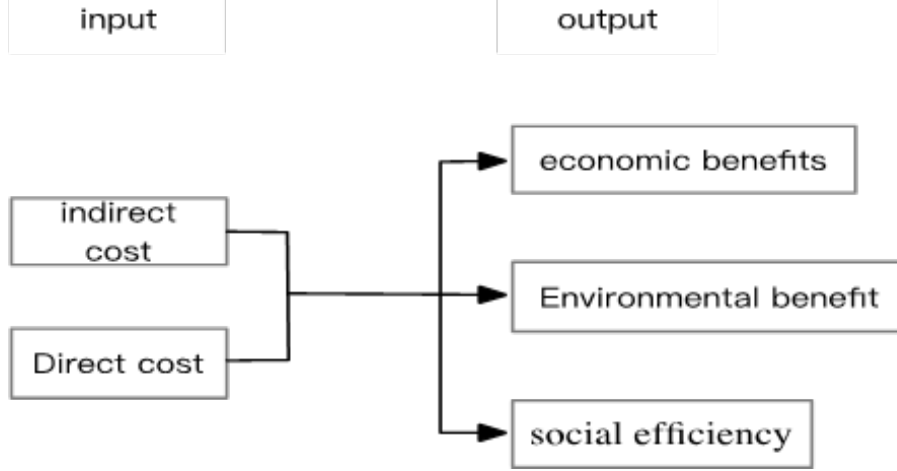
Figure 1. Input-output Items of Green Building.